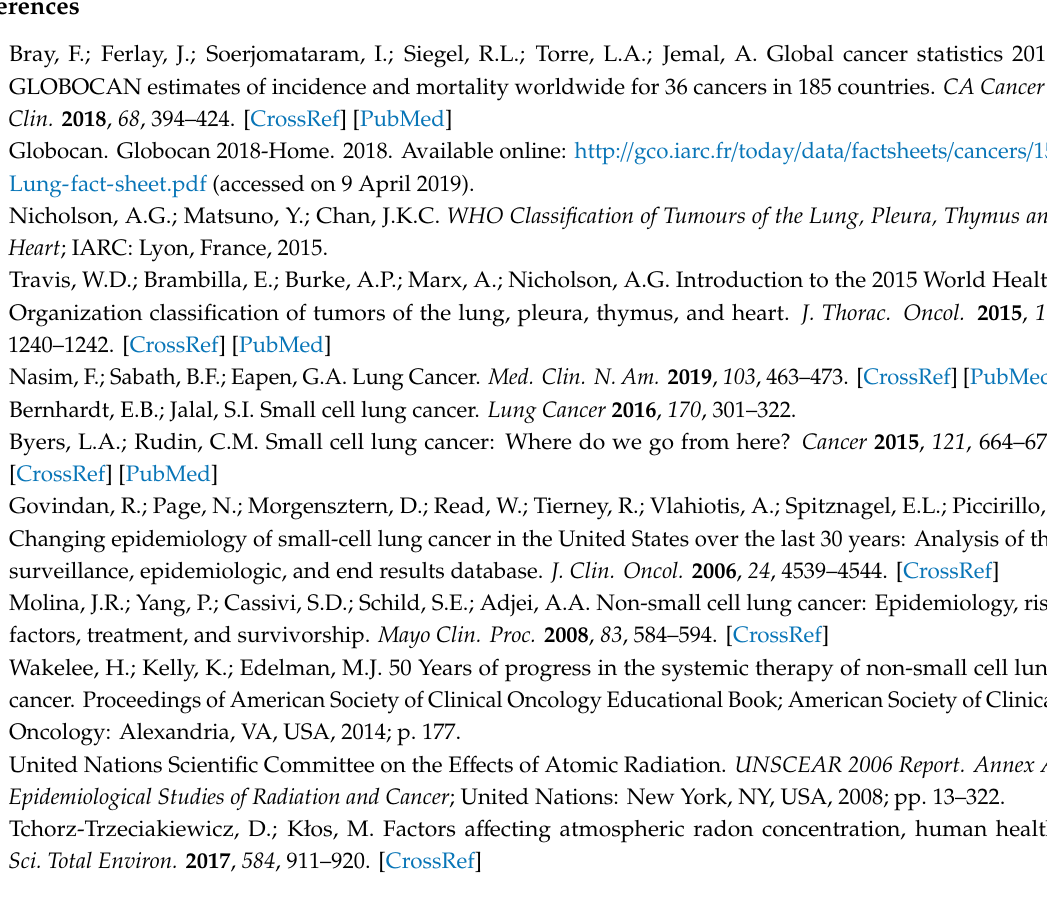
Figure S1: Funnel plots for the meta-analyses: overall pooled analysis, Figure S2: Funnel plots for the meta-analyses: histology subgroup analyses, Table S1: strategies of electronic database